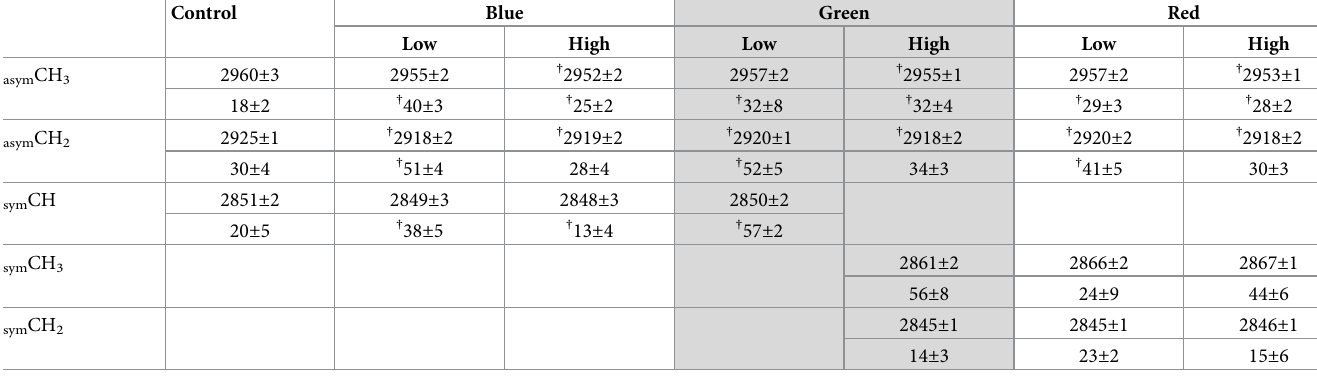
Table 2. Analysis of the CH region showing the underlying peaks vibrational frequency (cm -1 ) and the corresponding bandwidth (cm -1 ). Control Blue